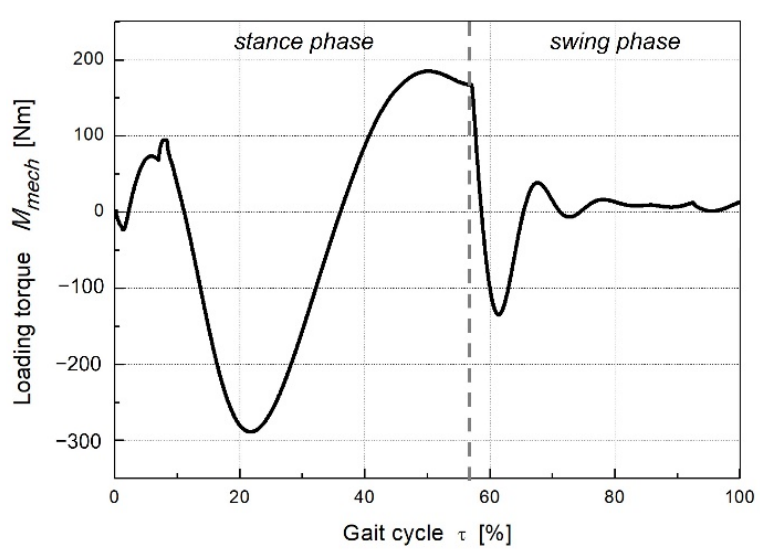
Figure 7. Graph of the torque transmitted by the hip joint over the entire gait cycle.